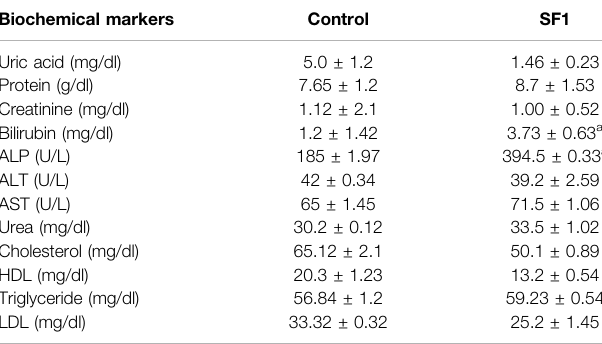
TABLE 6 | Estimation of biochemical markers in acute oral toxicity. Biochemical